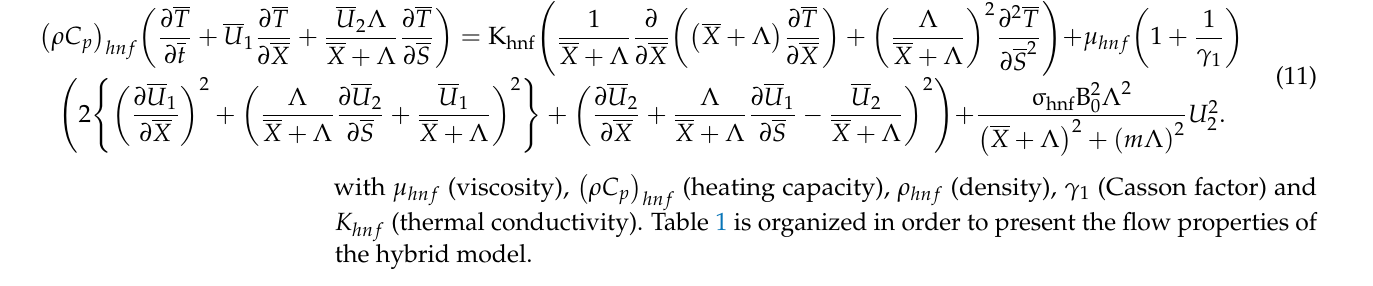
Table 1. Hybrid nanofluid different consequences with mathematical forms